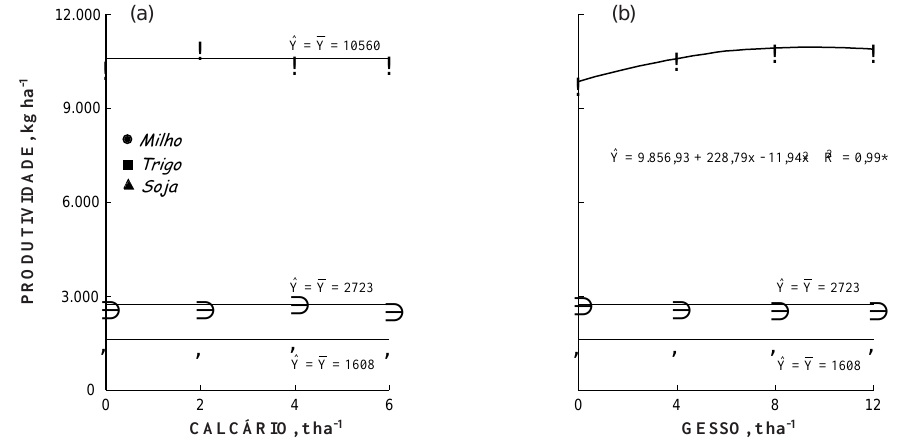
Figura 8. Efeito da calagem (a) e da aplicação de gesso (b) sobre a produção de grãos de milho, trigo e soja. (a: médias de quatro doses de gesso; b: médias de quatro doses de calcário). *significativo a